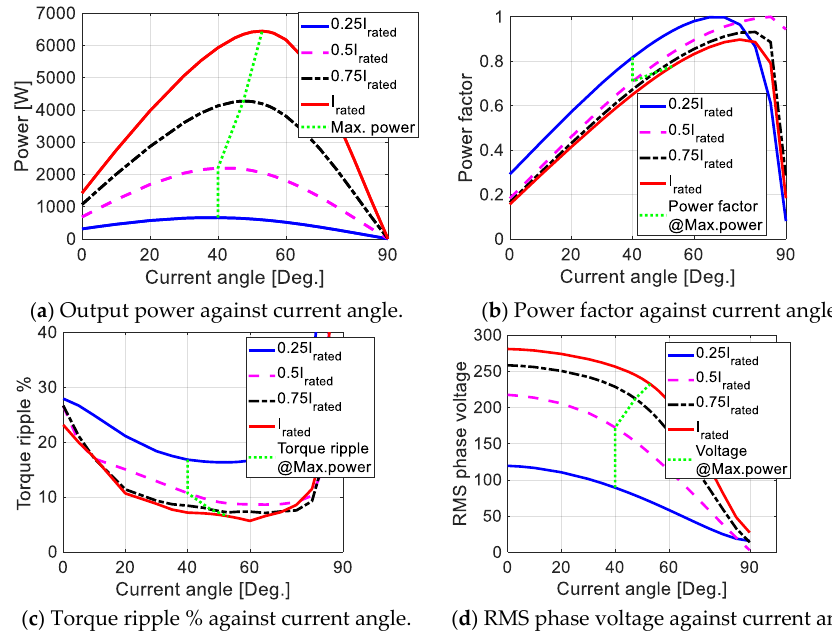
Figure 3. FMSynRM performance at 3000 rpm.